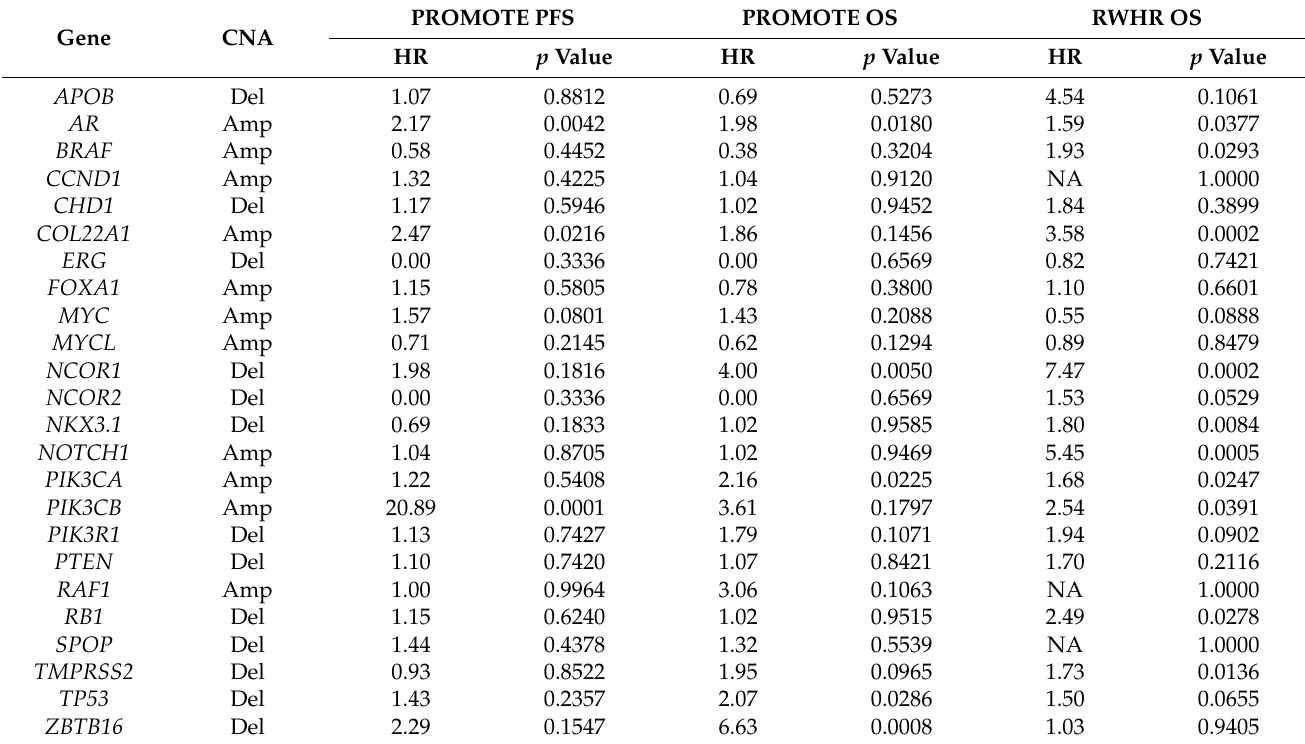
Table 2. Cox regression analysis results in the PROMOTE and RWHR